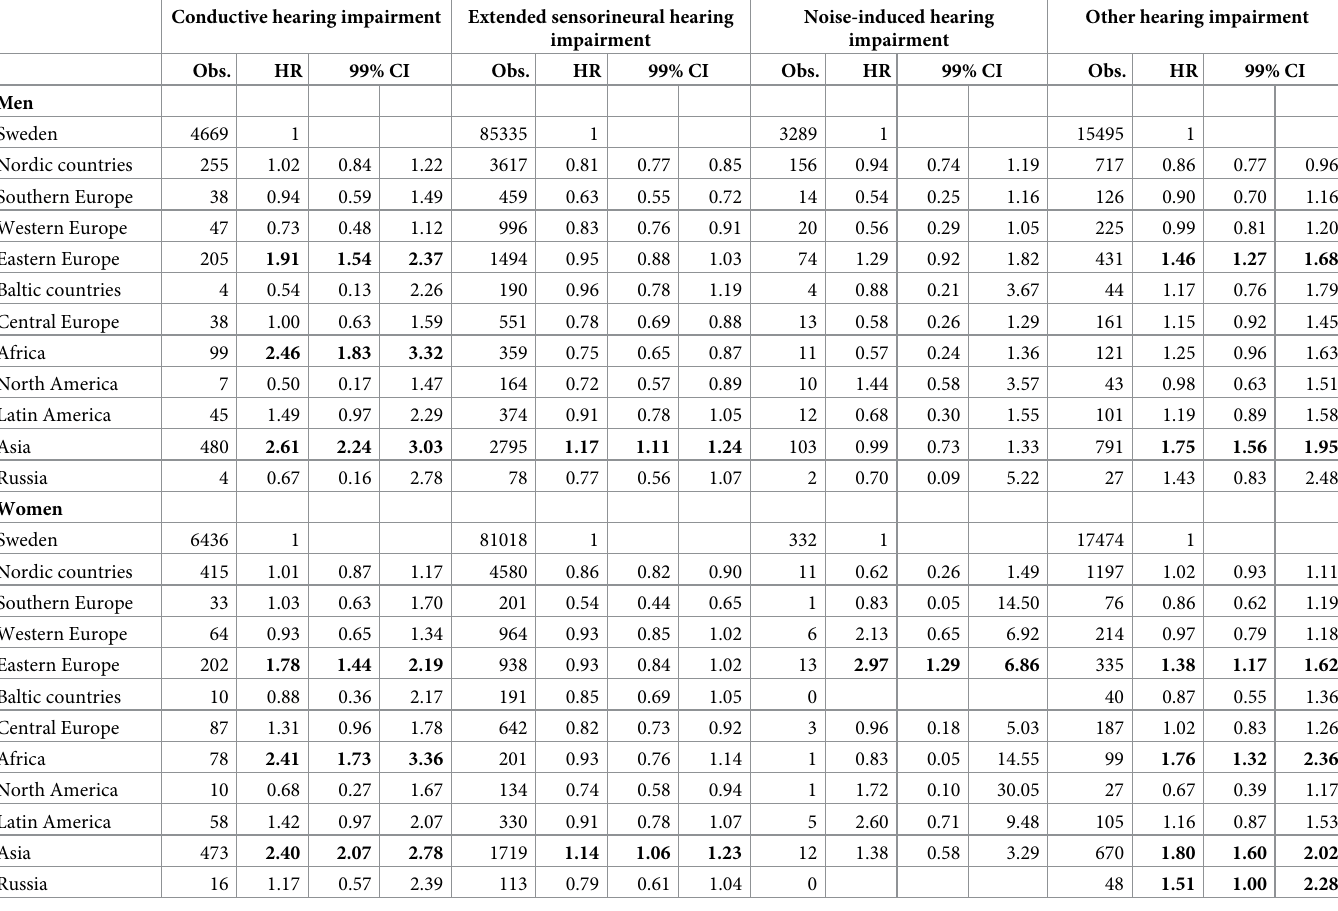
Table 3. Relative risks of conductive hearing loss and other types of hearing loss in foreign-born men and women with Swedish-born men and women as referents, respectively, expressed as hazard ratios (HR) with 99% confidence intervals (99% CI) � . Conductive hearing